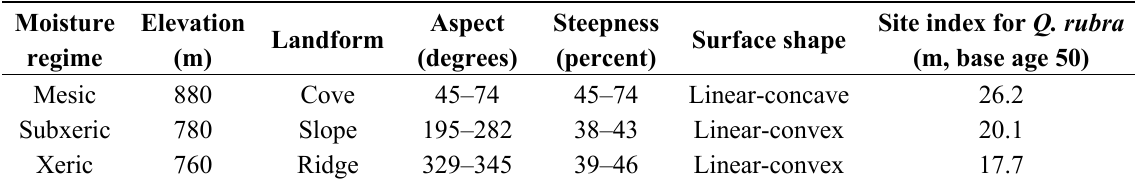
Table 1. Topographic characteristics of the